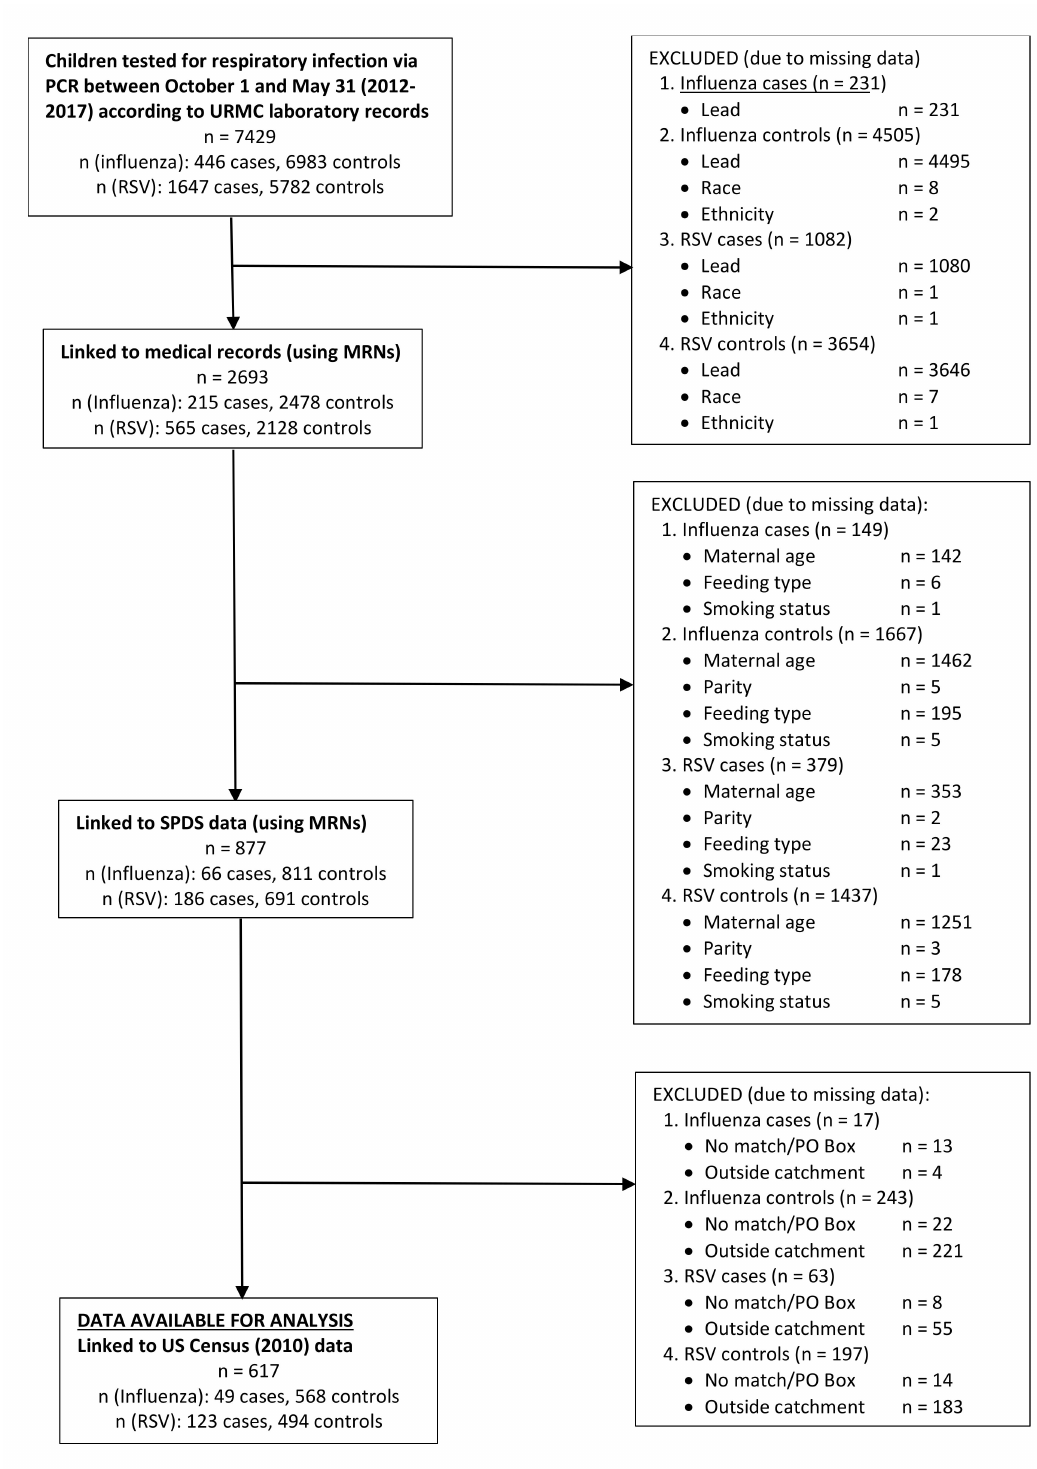
Figure 1. Flowchart Describing Collection of Influenza and Respiratory Syncytial Virus (RSV), Data Sources, Covariables of Interest, and Missingness for the Sample with Complete